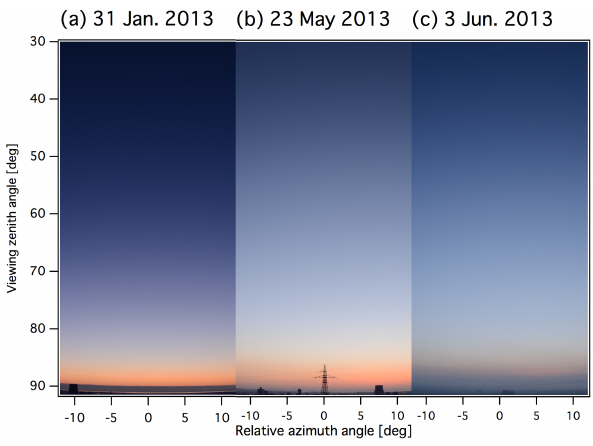
Figure 11. Photographs of twilight sky on the solar side, for the case studies of (a) 31 January, (b) 23 May, and (c) 3 June 2013. In all cases, SZA is uniformly 94 ◦ , and VZA is 90.45 ◦ at the hori- zon, 91.5 ◦ at the bottoms of the images, and 30 ◦ at the tops of the